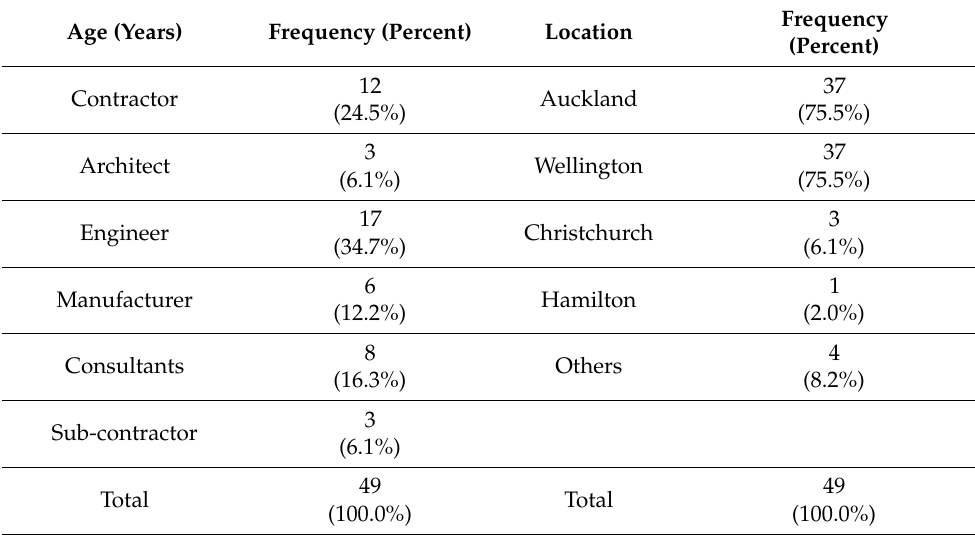
Table 2. Business category and participants’ location.